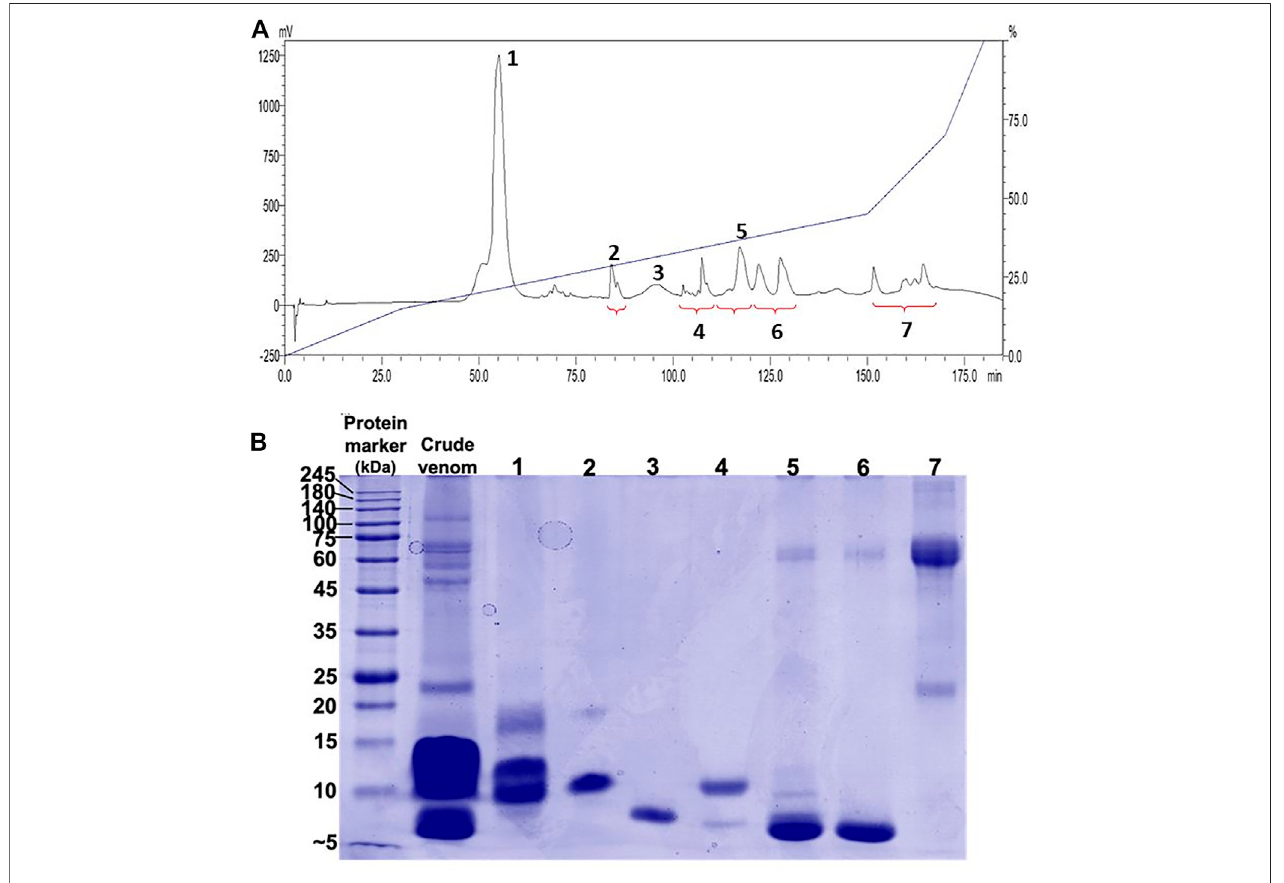
FIGURE 2 | Chromatographic and electrophoretic pro fi les of Naja samarensis venom. (A) Upper panel: C 18 reverse-phase high-performance liquid chromatography (RP-HPLC) of venom. (B) Lower panel: 15% polyacrylamide gel electrophoresis (SDS-PAGE) pro fi le of RP-HPLC eluted fractions electrophoresed under reducing